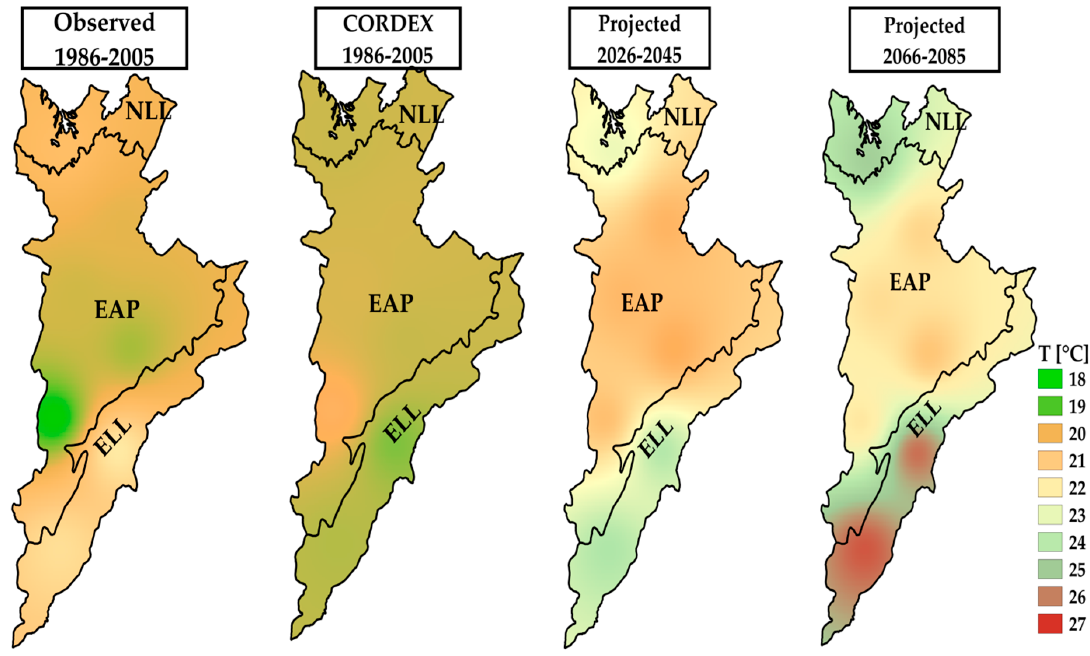
Figure 7. Historical and projected annual mean temperature over the periods 2026–2045 and 2066–2085 at EAP, ELL, and NLL.